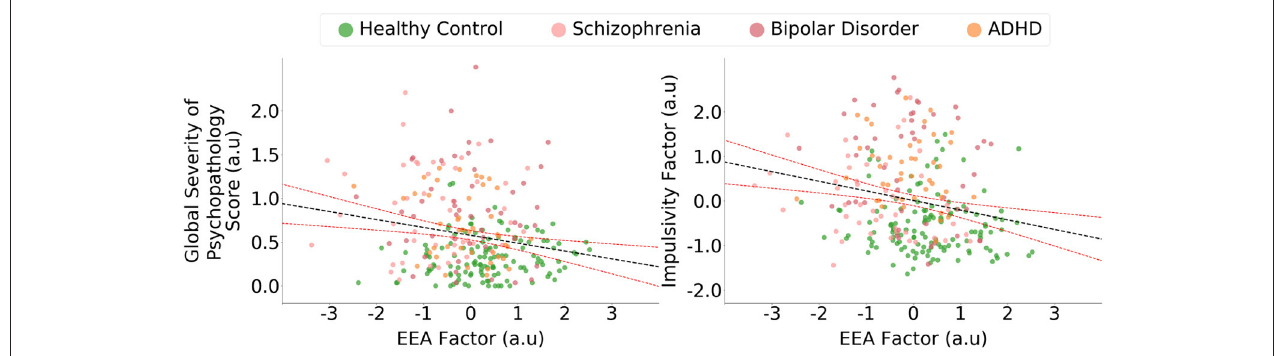
FIGURE 5 | Evidence accumulation is related to global psychopathology and impulsivity. The efficiency of evidence accumulation (EEA) factor was statistically significantly correlated with a global psychopathology severity score derived from a self-report general symptom scale. The evidence accumulation factor was also significantly correlated with an impulsivity factor derived from three self-report scales of trait impulsivity. Confidence intervals represent 95% predictive intervals, a.u., arbitrary units.